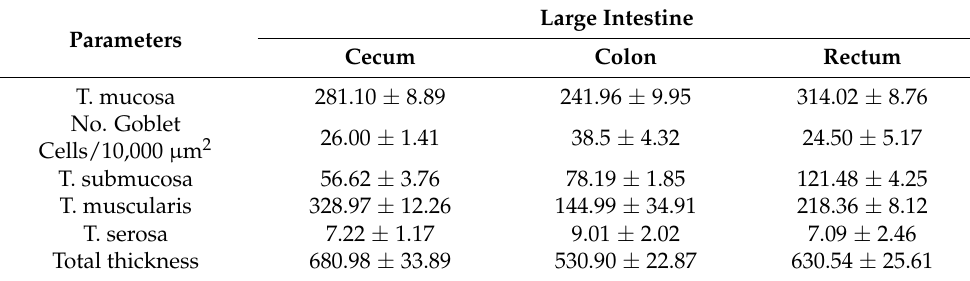
Table 4. The histometric measurements ( µ m) of the large intestine of adult male D. leporina ( n = 6).